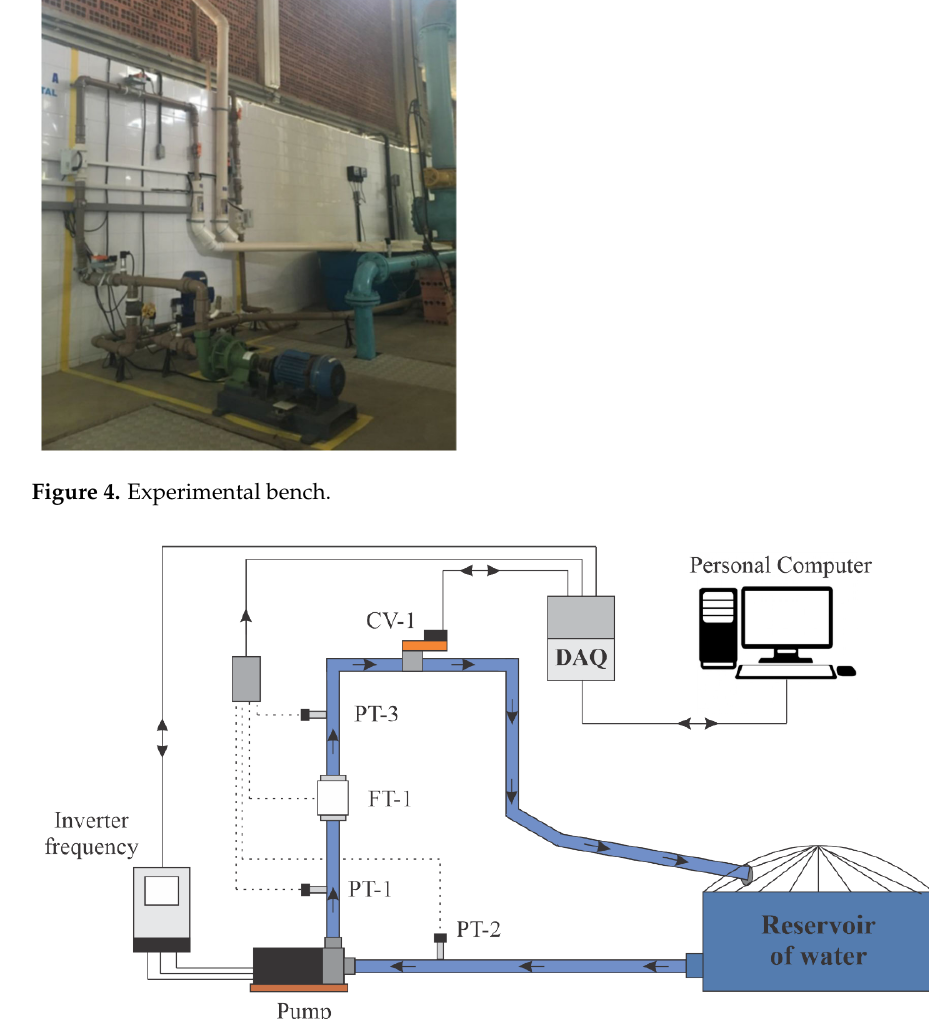
Figure 5. Bench schematic [4].